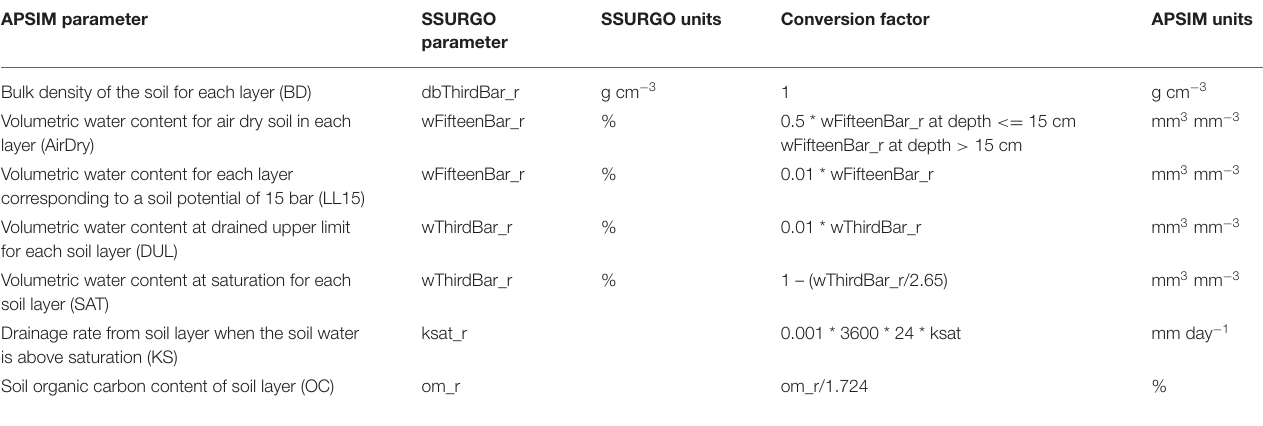
TABLE 2 | Derivation of APSIM soil properties from available SSURGO soil attribute data. APSIM